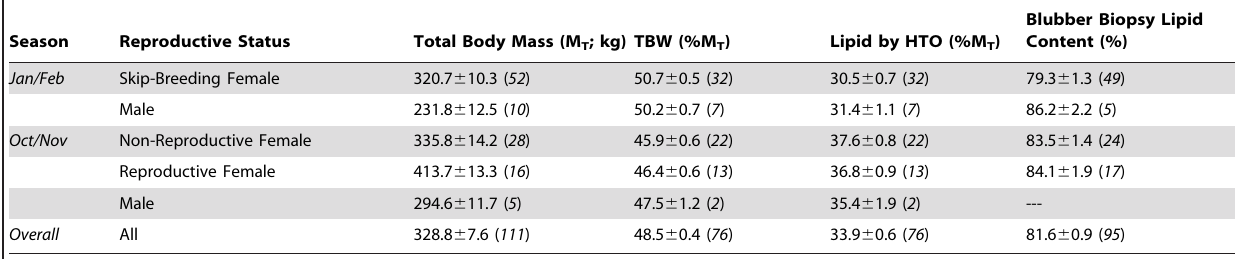
Table 1. Sample sizes and means 6 SE for body mass and composition.